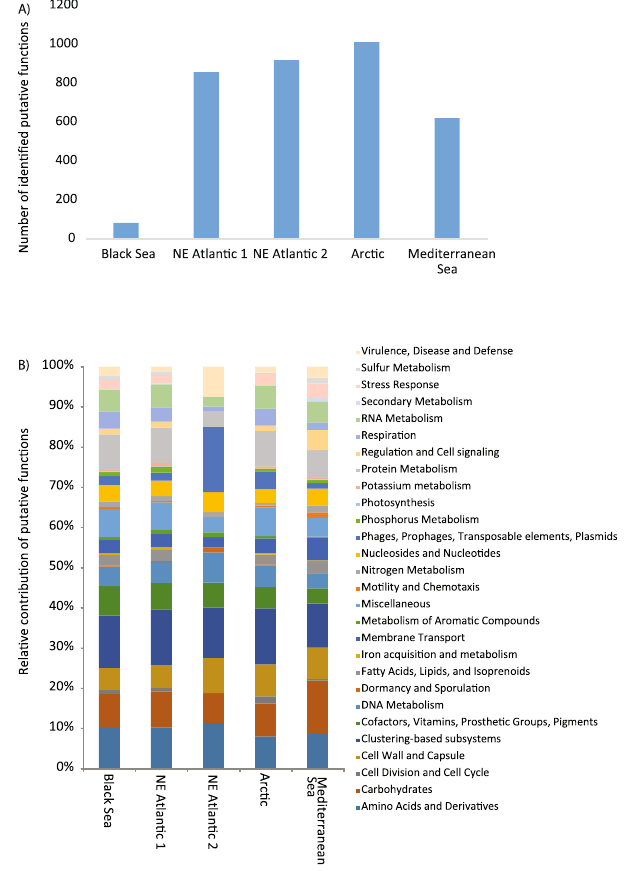
Figure 5. Putative functional richness ( A ) and contribution of functions belonging to each functional class to the total number of functions ( B ) identified by MG-RAST and Subsystems database (with default parameters) within each virome.